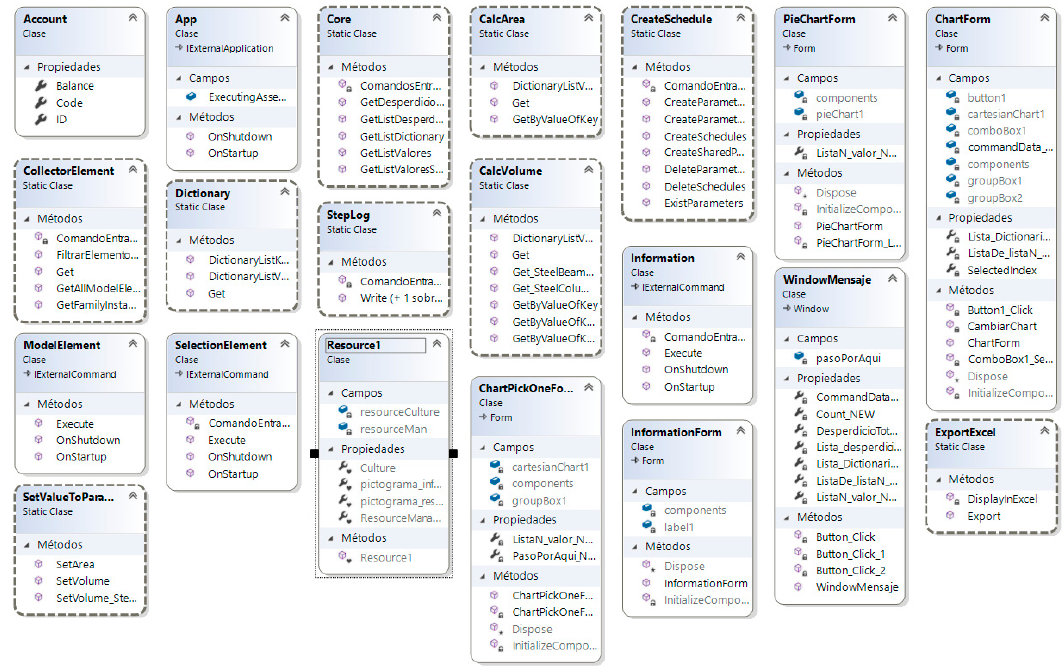
Figure 4. WE-BIM Add-in: Class diagram in Visual Studio.